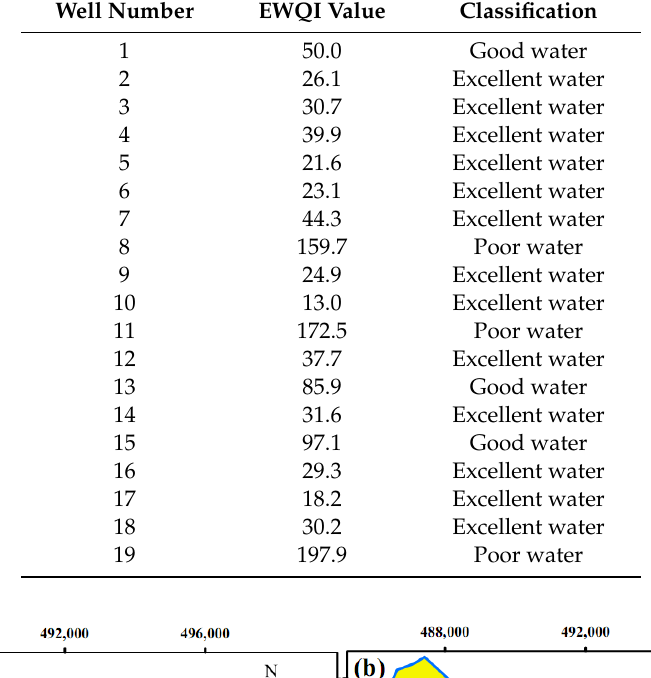
Table 4. EWQI for groundwater in the study area.